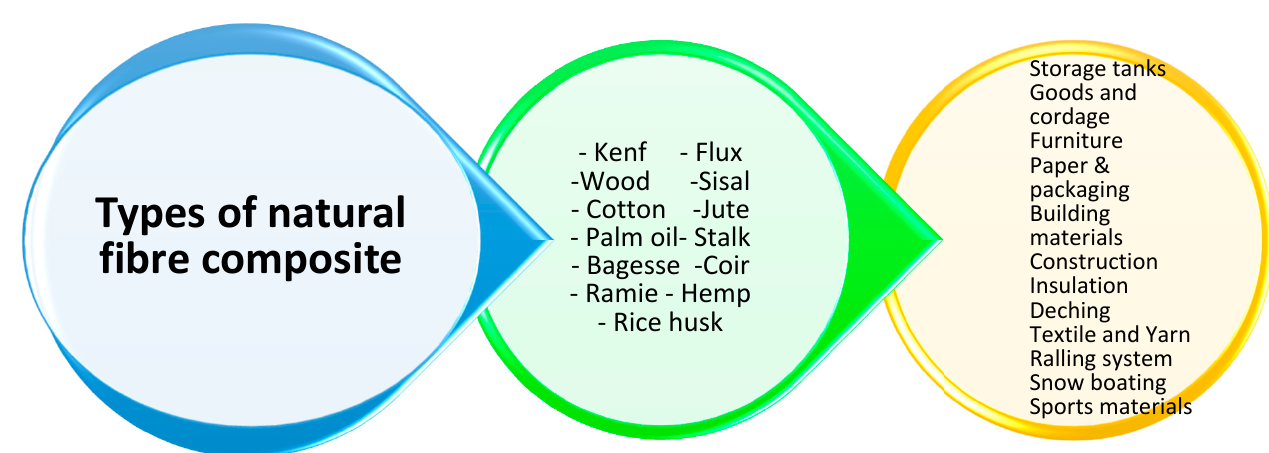
Figure 11. Application of various natural